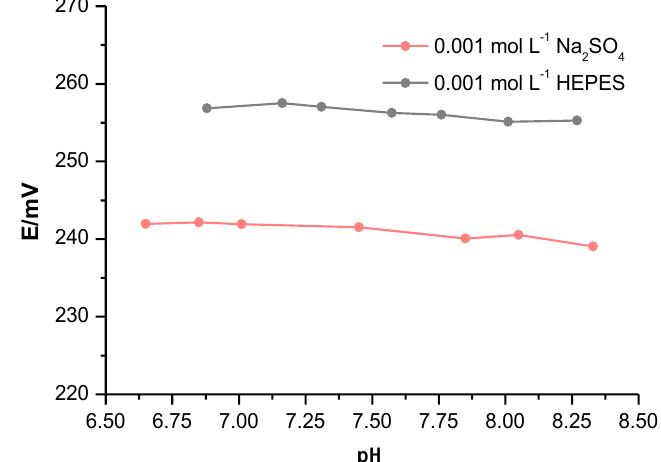
Figure 5. Effect of pH on the response of the potentiometric bicarbonate electrodes. The measurements were performed in HEPES buffer solution or Na 2 SO 4 . NaOH was used to change the pH.